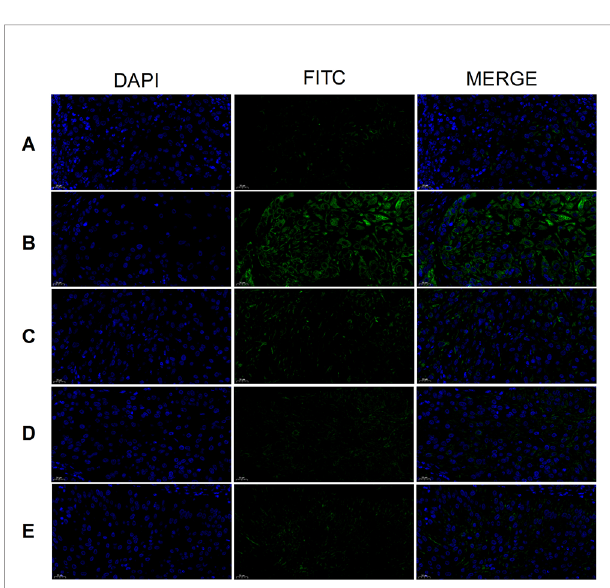
TABLE 3 | IL-4, IL-10, IL-13, and TGF- b 1 expression. Group IL-4(pg/ml)